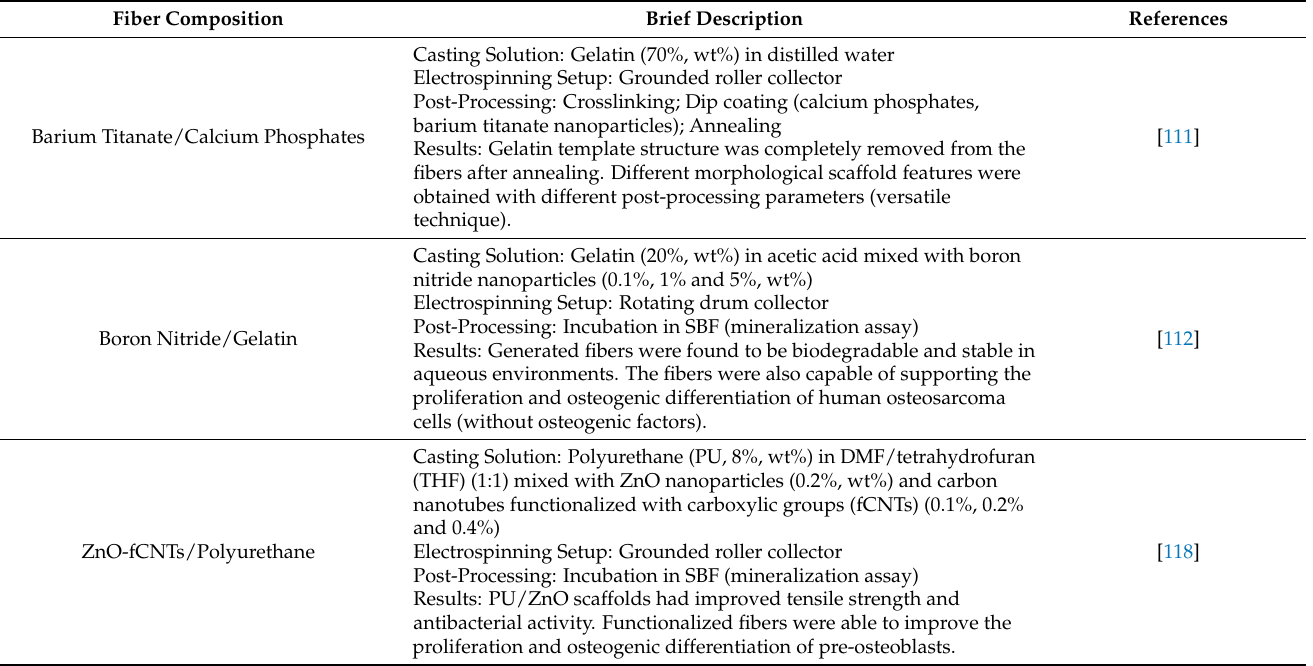
Table 6. Examples of piezoceramic or PZP-based electrospun piezoelectric nanofibers described in the literature for bone TE